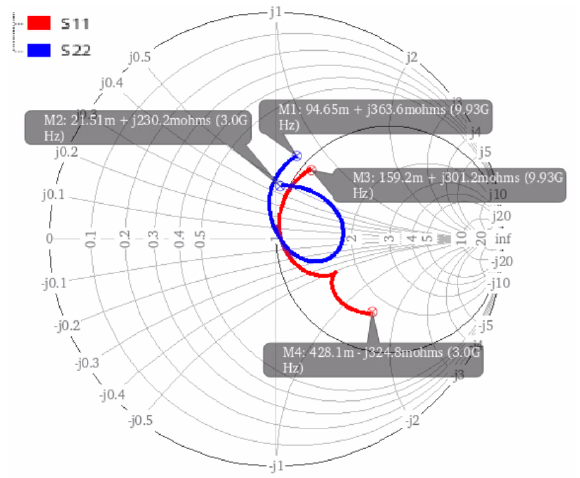
Figure 9. Frequency behavior of ( S 11 ) and ( S 22 ) on Smith